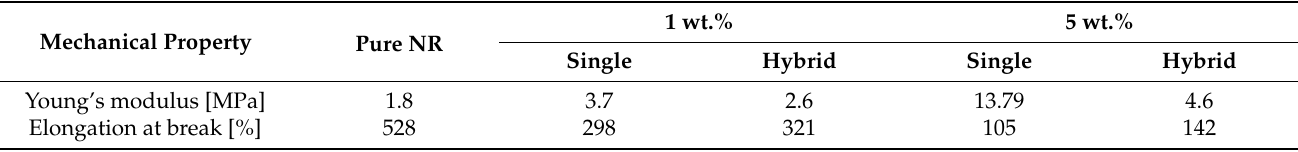
Figure 4. Strain–stress curve of pure NR and MWNT/NR composite according to each concentration Figure 4. Strain – stress curve of pure NR and MWNT/NR composite according to each concentration and structural formation pathway. and structural formation pathway. Table 1. Mechanical properties of pure NR and MWNT/NR